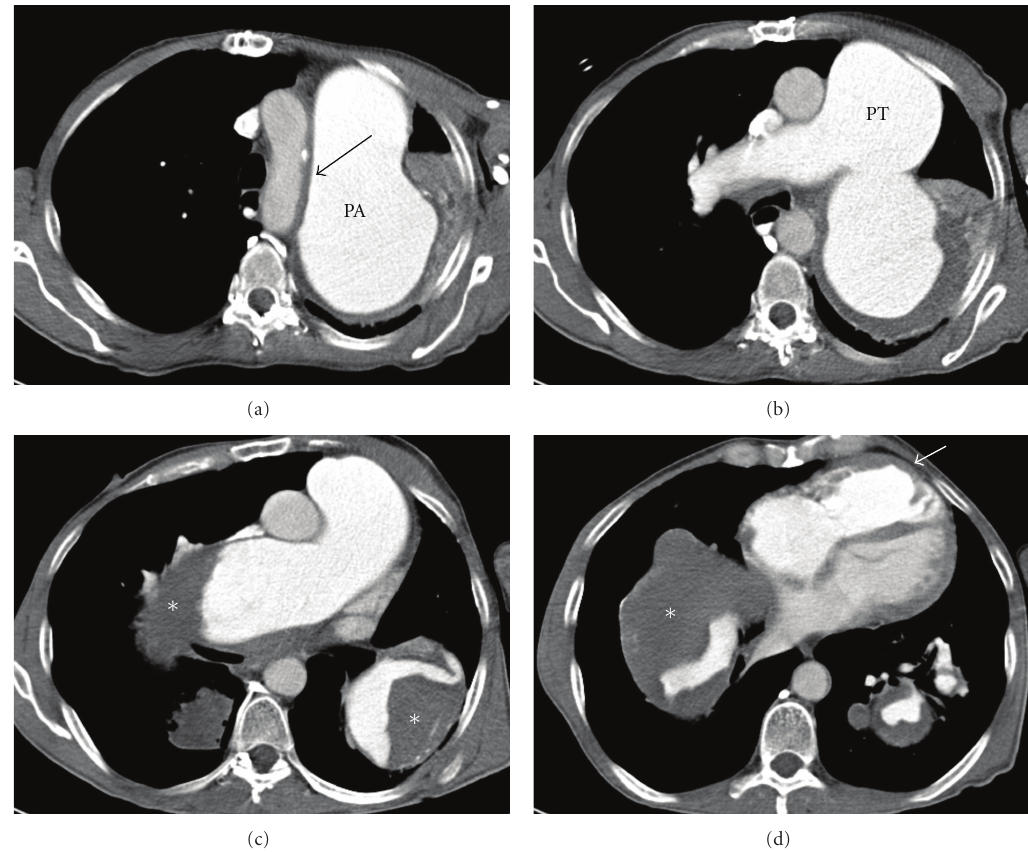
Figure 3: Chest CT featured the signs of pulmonary arterial hypertension, pulmonary trunk (PT) dilatation, aneurysmal dilatation of the central pulmonary arteries (PA), wall-adherent thrombotic material in pulmonary arteries (asterix), right ventricular hypertrophy (white arrow in (d)). No mass lesion or lymphadenopathy was found and the radiologist suggested the cardiovocal syndrome as a possible diagnosis because of the obvious mass e ff ect caused by the dilated central pulmonary arteries. The possible compression of the left recurrent laryngeal nerve between the aorta and pulmonary artery is well appreciated (black arrow in